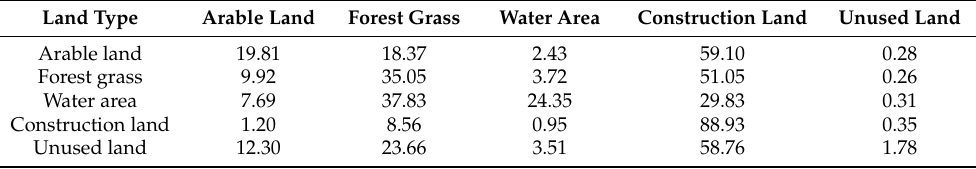
Figure 5. Analysis of water and other land types. Note: “Into” represents the transformation of other land-use types into water areas, and “Out” indicates the transformation of water areas into other land-use types. Table 6. The conversion area proportion of different land-use types (unit: %).